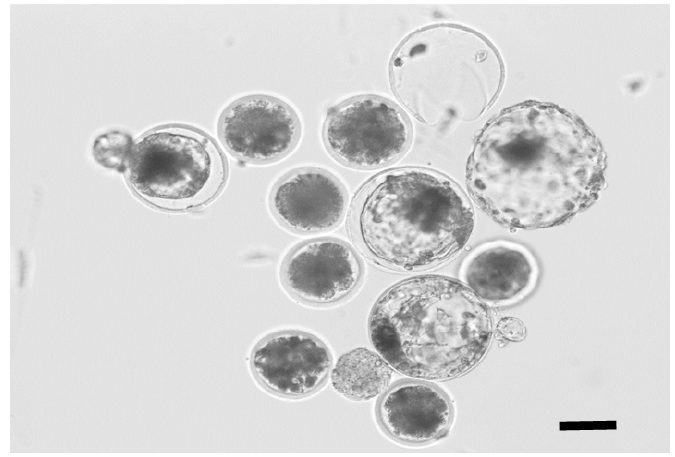
Figure 4. An image of in vitro fertilization (IVF)-derived blastocysts using spermatozoa from the 1/4-L cutting region of the semen straw. The black bar is 100 µm.